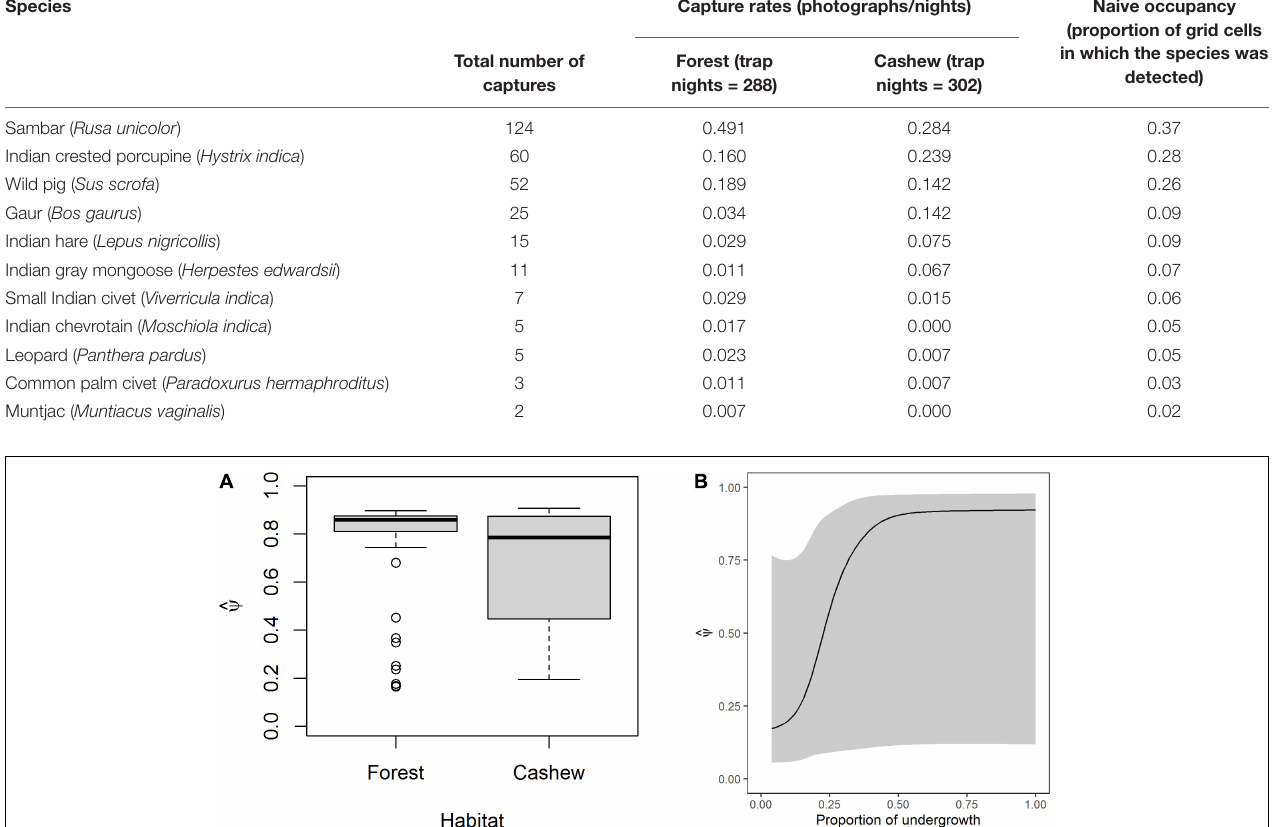
TABLE 2 | Camera trap capture statistics of terrestrial mammal species surveyed in Tillari region from January to April 2016. Species Capture rates (photographs/nights) Naive occupancy